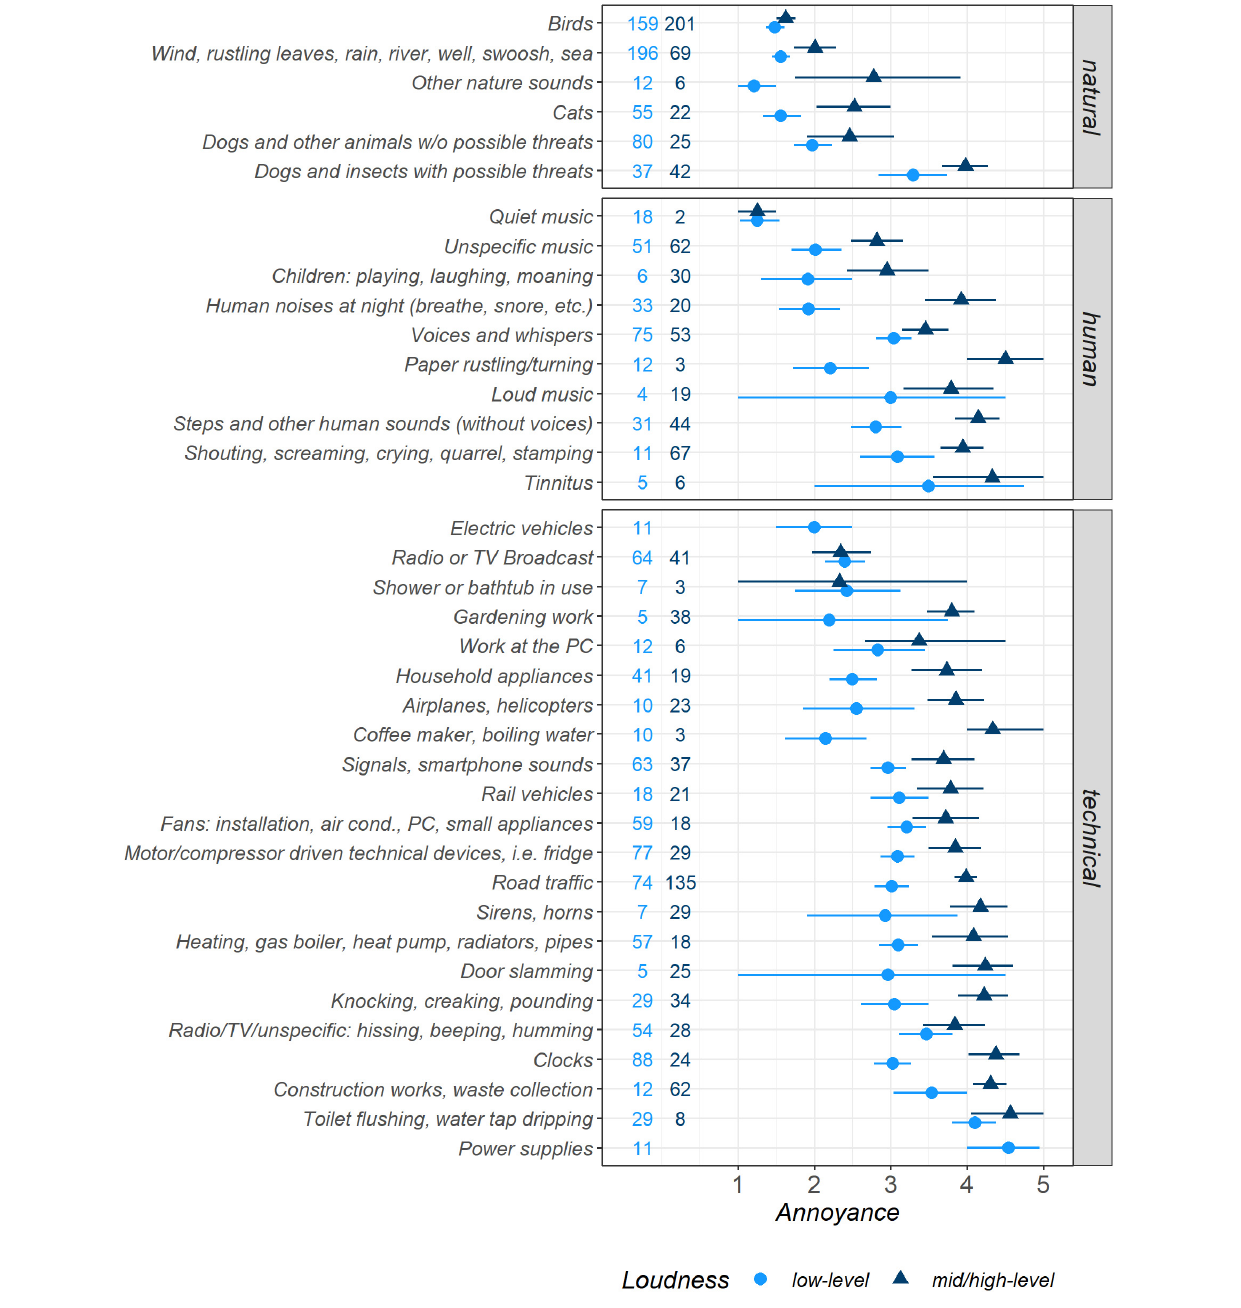
FIGURE A1 | Estimated marginal means for Annoyance for sounds from 38 micro-level sound categories , separated by binary Loudness levels, displayed with 95% confidence intervals (both determined by bootstrapping) and the numbers of observations per category and Loudness level subsets. Very pleasant = 1, very annoying = 5. Models Micro3a and Micro3b